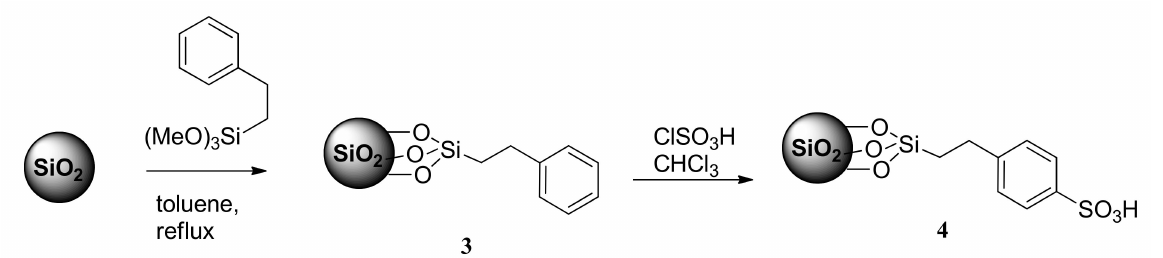
Figure 2. Synthesis of arenesulfonic MCM-41 based on Lindlar studies